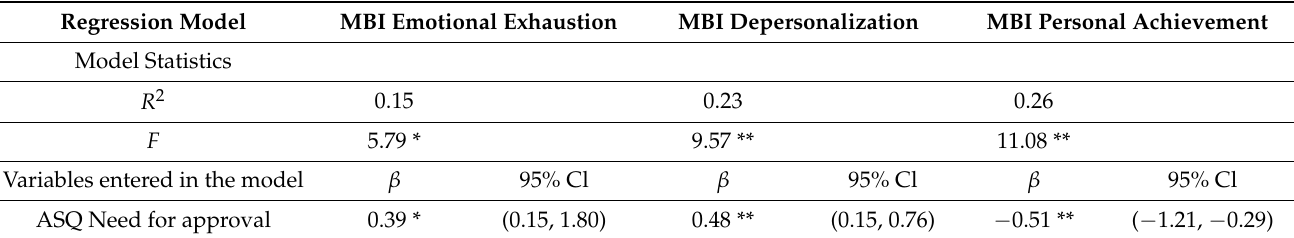
Table 2. Predictors of burnout in nurses ( n